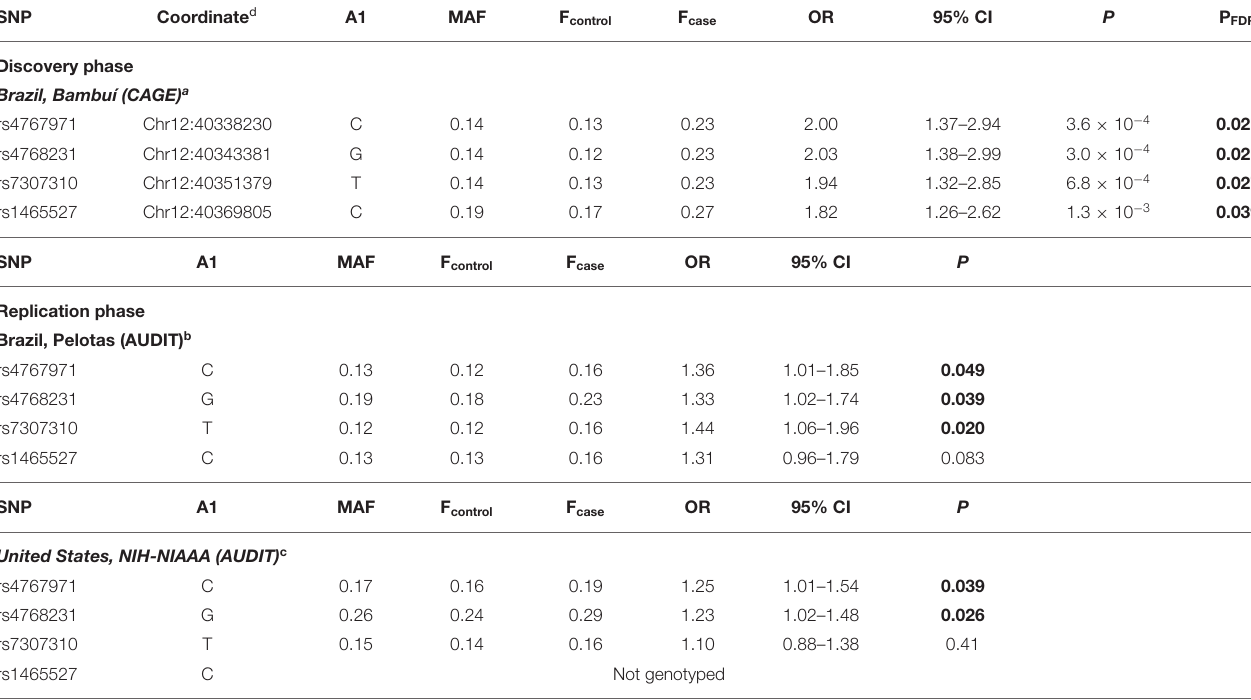
TABLE 2 | Markers in the LRRK2 locus associated with alcohol dependence in humans. SNP Coordinate d A1 MAF F control F case OR 95% CI P P